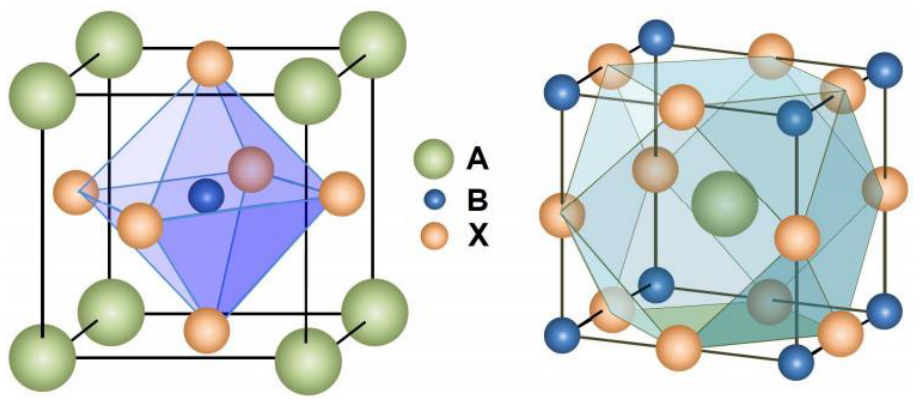
Figure 4. The basic structure of perovskite ABX3 [43]. CsPbBr 3 perovskite material belongs to the orthorhombic crystal system [44], as shown in Figure 5, where Cs + is located in the cell center and forms AX 12 dodecahedra with neighboring halogen atoms. Pb 2+ ions at the B-site are coordinated with the neighboring six halogen element ions to form PbX 6 octahedra. PbX 6 octahedra extend in three dimensions to form a framework structure.